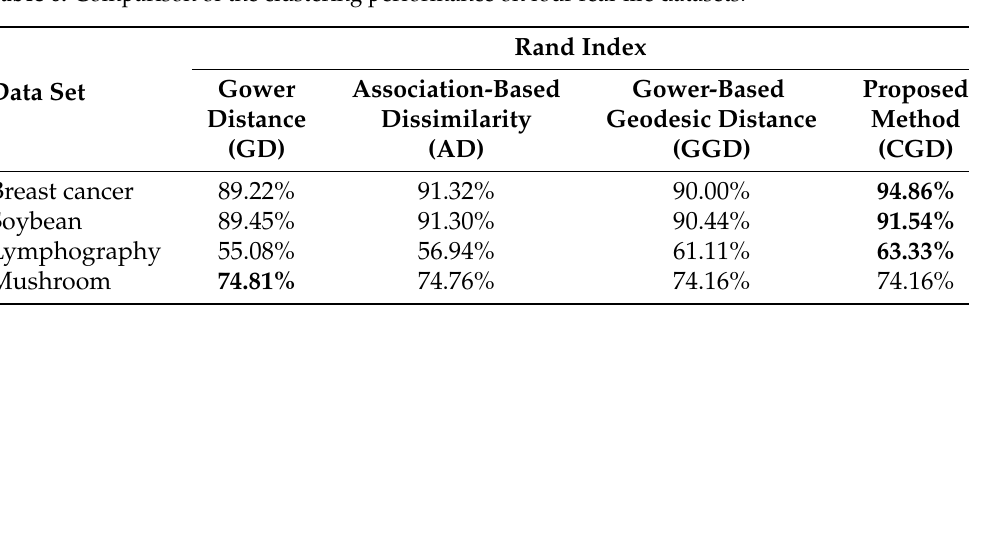
Table 6. Comparison of the clustering performance on four real-life